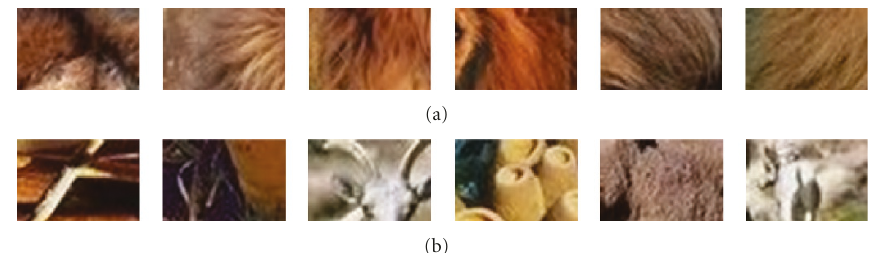
Figure 5: Positive (a) and negative (b) representative sample blocks of lion